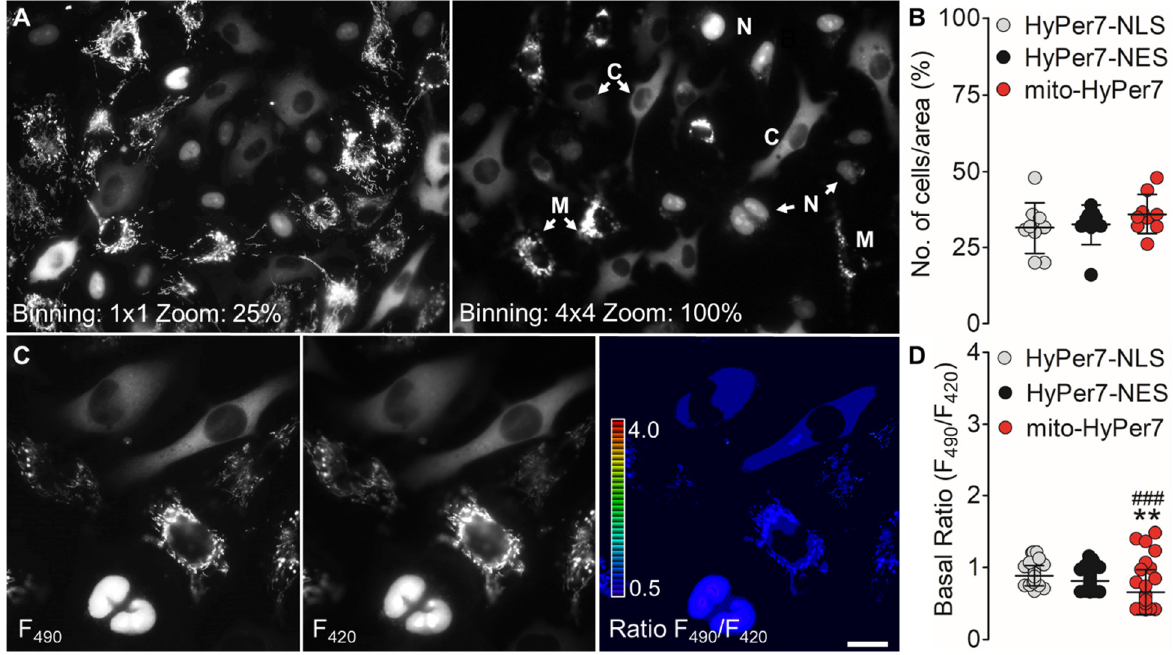
Figure 2. Characterization and analysis of co-cultured cell lines. ( A ) Micrographs show the distribution of co-cultured EA.hy926 cells expressing nuclear-, cytosolic-, and mitochondria-targeted HyPer7. The representative widefield images were captured using high-resolution settings (binning of 1 × 1, left image) and low-resolution settings (binning 4 × 4, right image). Subcellular localization is indicated with N for nucleus, C for cytosol, and M for mitochondria. Both images were taken with a 40× oil objective. ( B ) Scatter dot plot represents the statistical analysis of the distribution of differently targeted cells in percent in a random field of view. Nuclear-targeted HyPer7 (grey dots, n = 9/76), cytosolic-targeted HyPer7 (black dots, n = 9/68), and mitochondria-targeted HyPer7 (red dots, n = 9/76). ( C ) Representative widefield images show EA.hy926 cells expressing differentially targeted HyPer7 in the HyPer high channel (left image, Ex: 490 nm, Em: 520 nm) and HyPer low channel (middle image, Ex: 420 nm, Em: 520 nm). The right image shows the resulting ratio images (HyPer high channel divided by the HyPer low channel). Scale bar represents 20 µm. ( D ) Scatter dot plot shows the statistical analysis of the basal ratio levels of cells expressing the nuclear-targeted HyPer7 (grey dots, n = 38), cytosolic-targeted HyPer7 (black dots, n = 35), and mitochondria-targeted HyPer7 (red dots, n = 36). One-way ANOVA and Bonferroni’s multiple comparison post-test were applied to compare all columns with each other. p < 0.0001 p -value summary (Basal ratios: Cyto vs. mito **, Mito vs. Nuc ###, Cyto vs. Nuc n.s.). All values are given as ±SD.